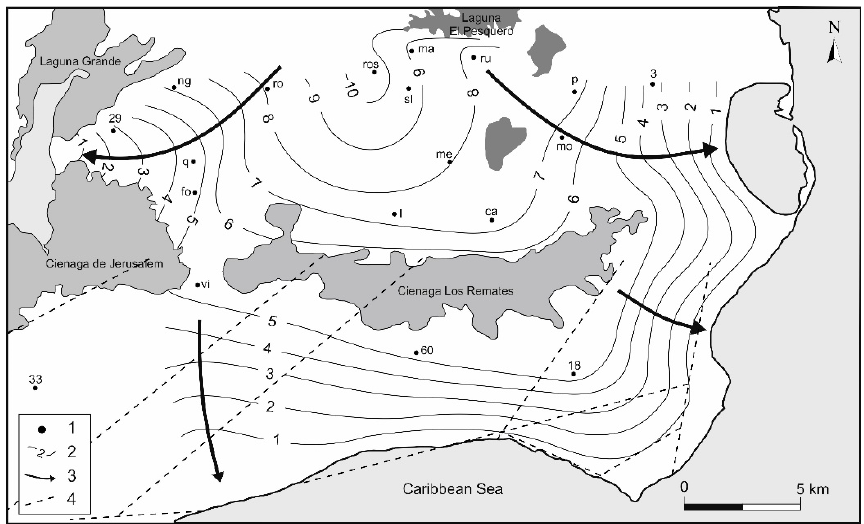
Figure 2. Hydrogeological map of site 1 in Figure 1. Legend: 1. well; 2. potentiometric contour line and hydraulic head in meters above sea level (m.a.s.l.); 3. main groundwater flow direction; 4. main fault.